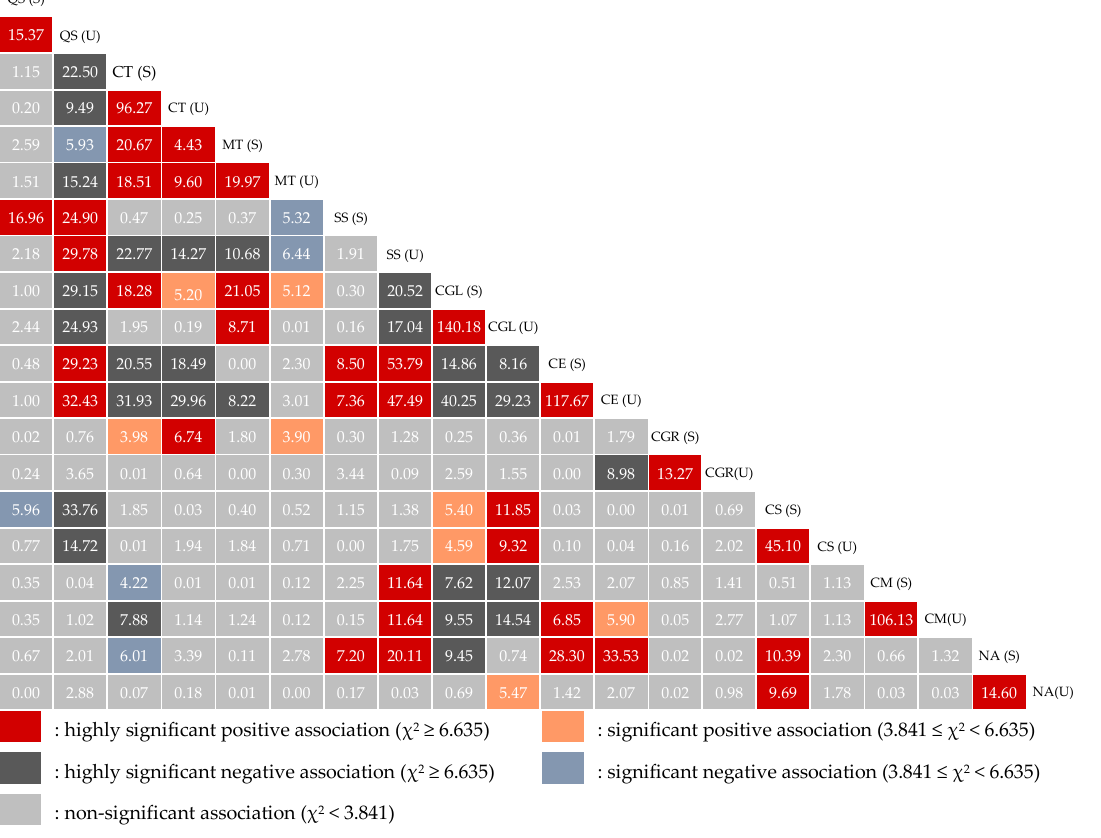
Figure 3. Correlation matrix of the χ 2 test results of the dominant species in the old-growth forest.